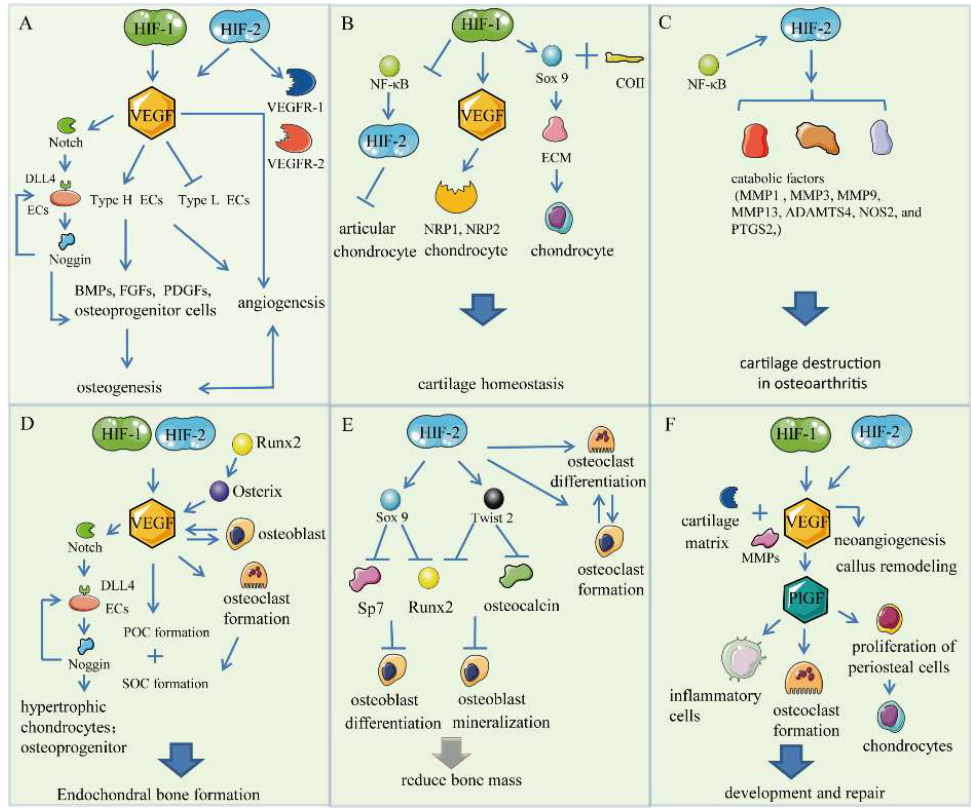
Figure 2. HIF/VEGF pathway. ( A ) Bone angiogenesis. VEGF is mediated by HIF-1 and HIF-2 to bone-specific ECs, type H, to promote bone angiogenesis. VEGF–Notch–Noggin pathway underscores the coupling that exists between angiogenesis and osteogenesis. ( B ) Chondrogenesis. VEGF binds to its receptors, NRP1 and NRP2, on the surface of chondrocytes. HIF-1 up-regulates Sox-9 and modifies COII after translation to promote cartilage homeostasis. ( C ) HIF-2 directly regulates catabolic factors to destroy cartilage in osteoarthritis. ( D ) Endochondral bone formation. HIF-1 and HIF-2 stimulate the expression of VEGF to promote the formation of the POCs and SOCs and mediate endochondral bone formation. ( E ) Regulation of bone mass by HIF-2. HIF-2 inhibits osteoblastic differentiation and mineralization. ( F ) Skeletal repair. HIF-1–VEGF–PlGF pathway plays a significant role in the